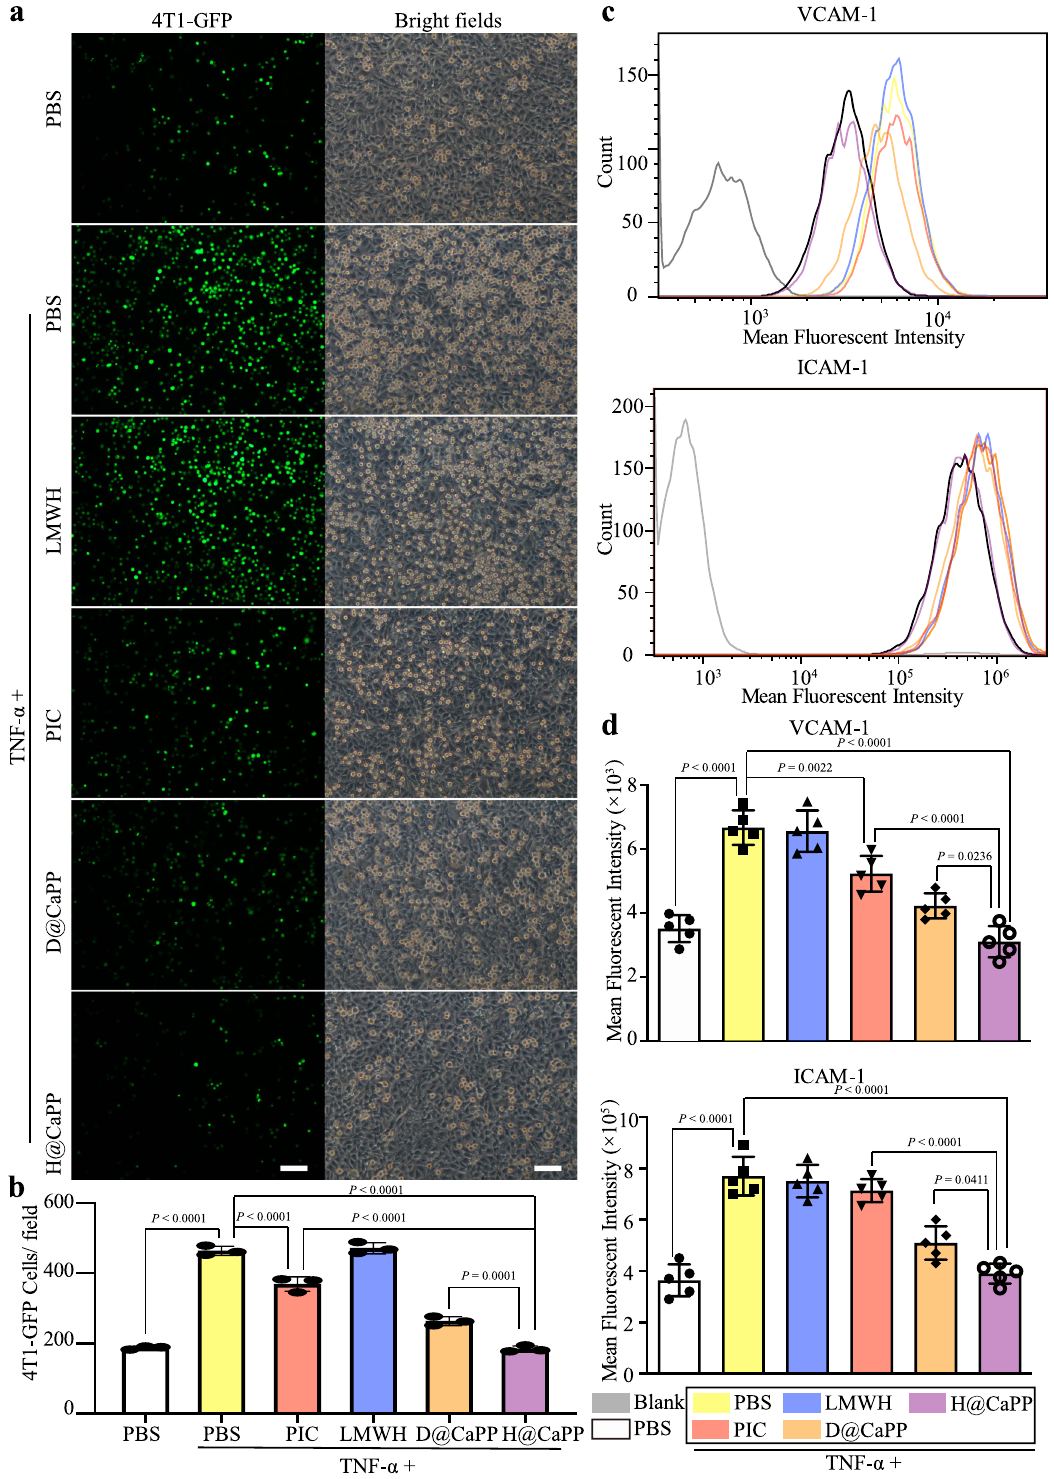
Fig. 7 Evaluation of the adhesion of ECs in the pre-metastatic site in vitro. a Images of 4T1 cells (labeled calcein-AM) adhered to HUVECs which were treated with PBS, TNF- α + PBS, TNF- α + LMWH, TNF- α + piceatannol, TNF- α + D@CaPP, and TNF- α + H@CaPP (TNF- α = 50 ng/mL, a dose of free piceatannol or PP at 10 μ M, dose of Dextran or LMWH at 1.3 mg/mL) for 24 h, respectively. Left photo, fl uorescent fi eld; right photo, bright fi eld. Scale bar, 50 μ m. b Number of 4T1 cells in per fi eld from each group (ANOVA, mean ± SD, n = 3 fi elds per group). c Flow cytometry analysis of VCAM-1 and ICAM-1 on HUVECs treated as a , respectively. Cells without the incubation of antibodies were served as blank control. d The fl uorescence intensity of VCAM-1 and ICAM-1 in each group (ANOVA, mean ± SD, n = 5 samples per group). One-way ANOVA with Tukey ’ s multiple comparisons test (one-sided) was used for b and d . Error bars represent